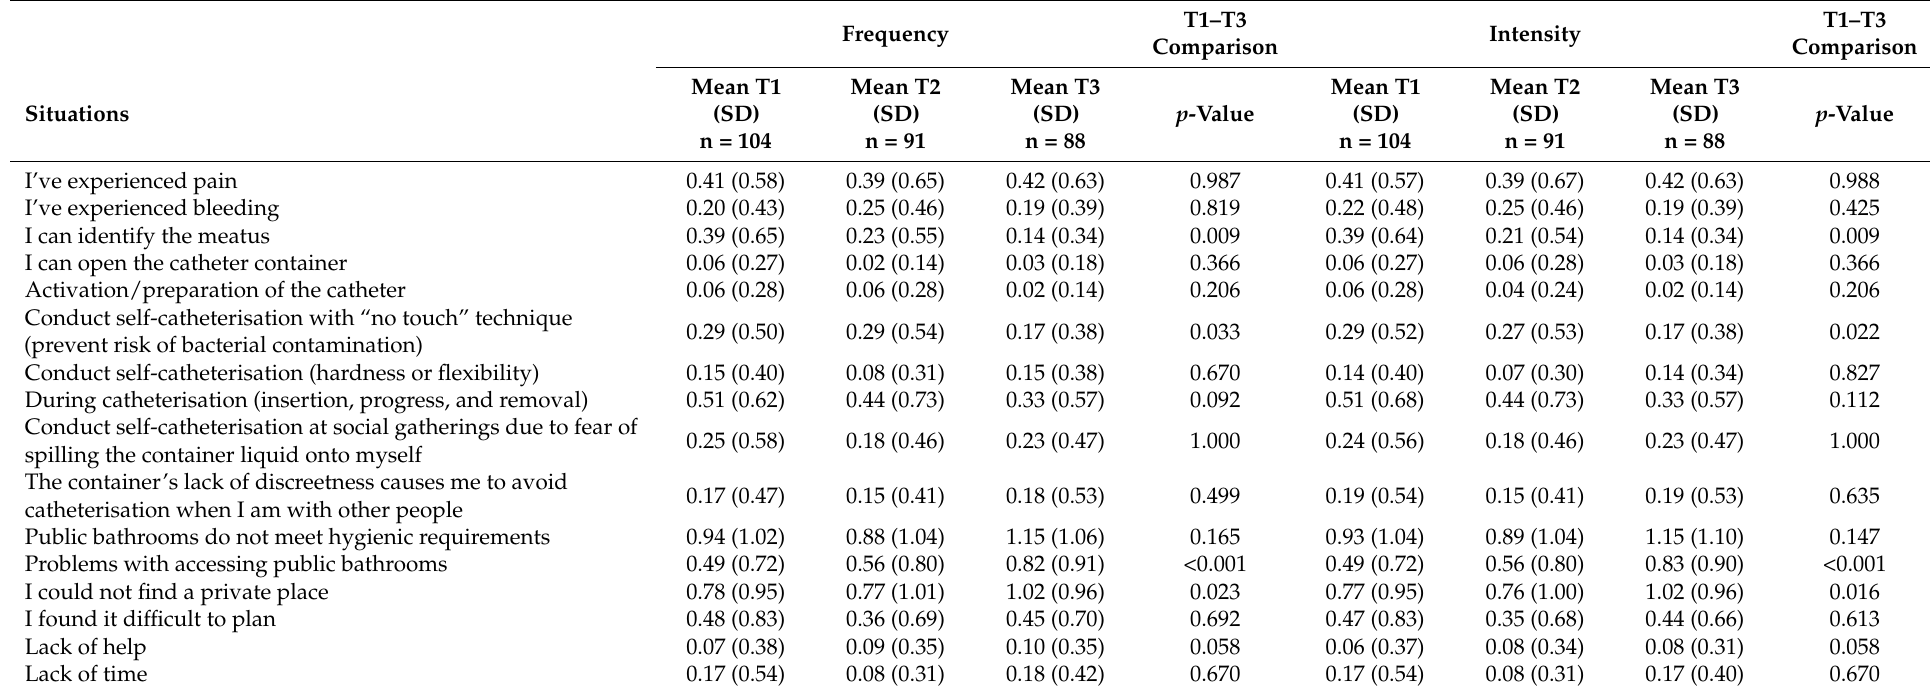
Table 8. Difficulty performing bladder catheterisation at the three cut-off points.